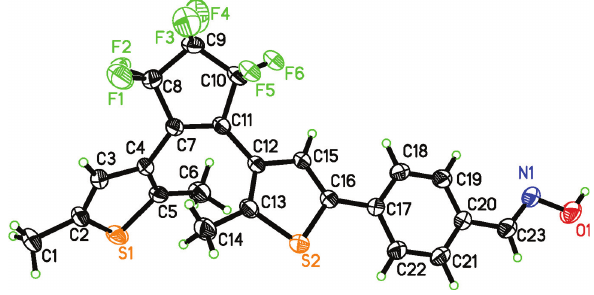
Table 1: Data collection and handling.